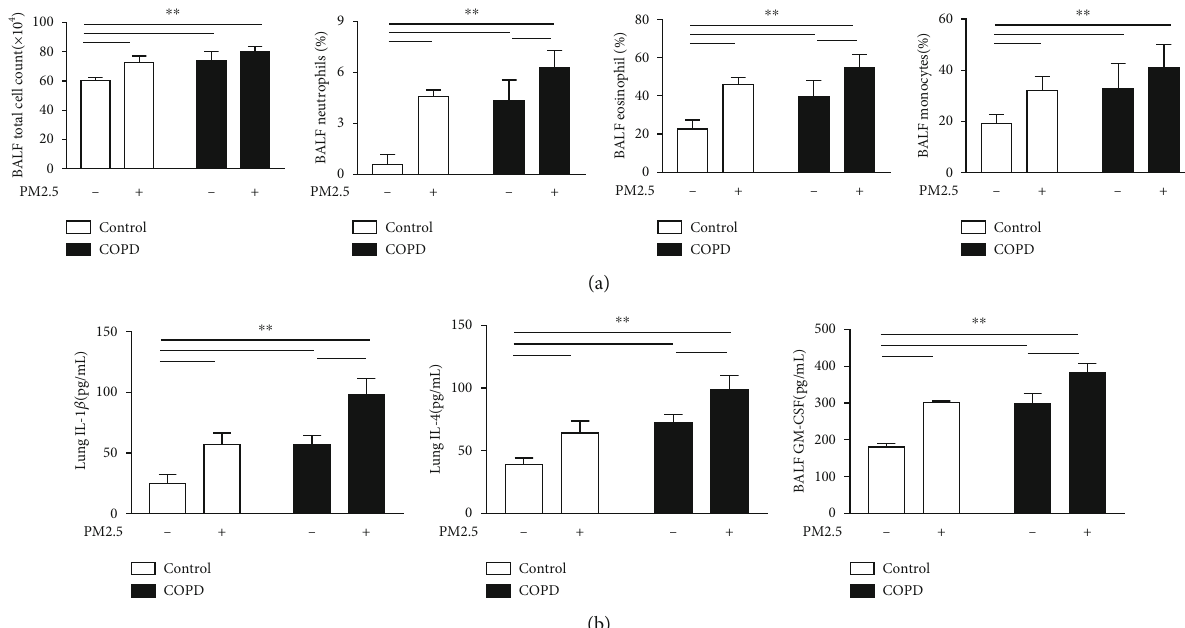
Figure 5: The e ff ect of PM2.5 on in fl ammatory response in rats with COPD. (a) The total cell count and percentage of neutrophils, eosinophils, and macrophages in the BALF of rats in each group. (b) Level of IL-1 β and IL-4 in the lung and GM-CSF in the BALF of rats in each group. IL-1 β : Interleukin-1 β ; IL-4: Interleukin-4; GM-CSF: granulocyte-macrophage colony-stimulating factor. The data are expressed as the means ± SD ( n = 7 ). ∗∗ p < 0 : 01 , ∗ p < 0 : 05 . 0.01.53.04.5